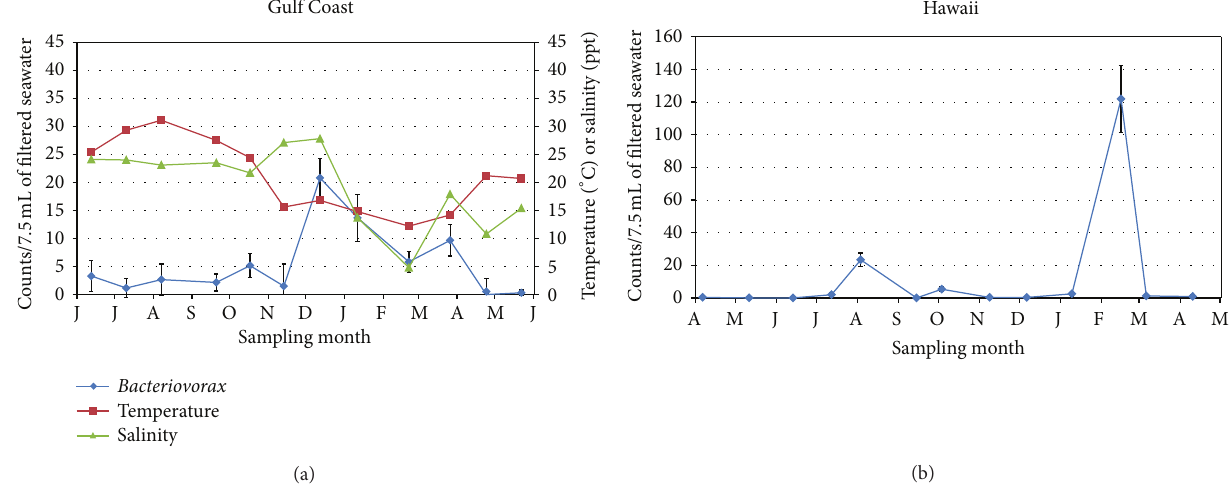
Figure 4: Monthly Bacteriovorax levels, seawater salinity, and temperature for (a) Gulf of Mexico site (starting in June 2012) for 1 year. (b) Bacteriovorax levels for Hawaiian site (starting in April 2012) for 13 months. Seawater temperature and salinity data are not shown for Hawaii because they remain steady between 24 and 25 ∘ C and at 35 ppt salinity. All monthly Bacteriovorax levels are the mean ± SD obtained from six samples.